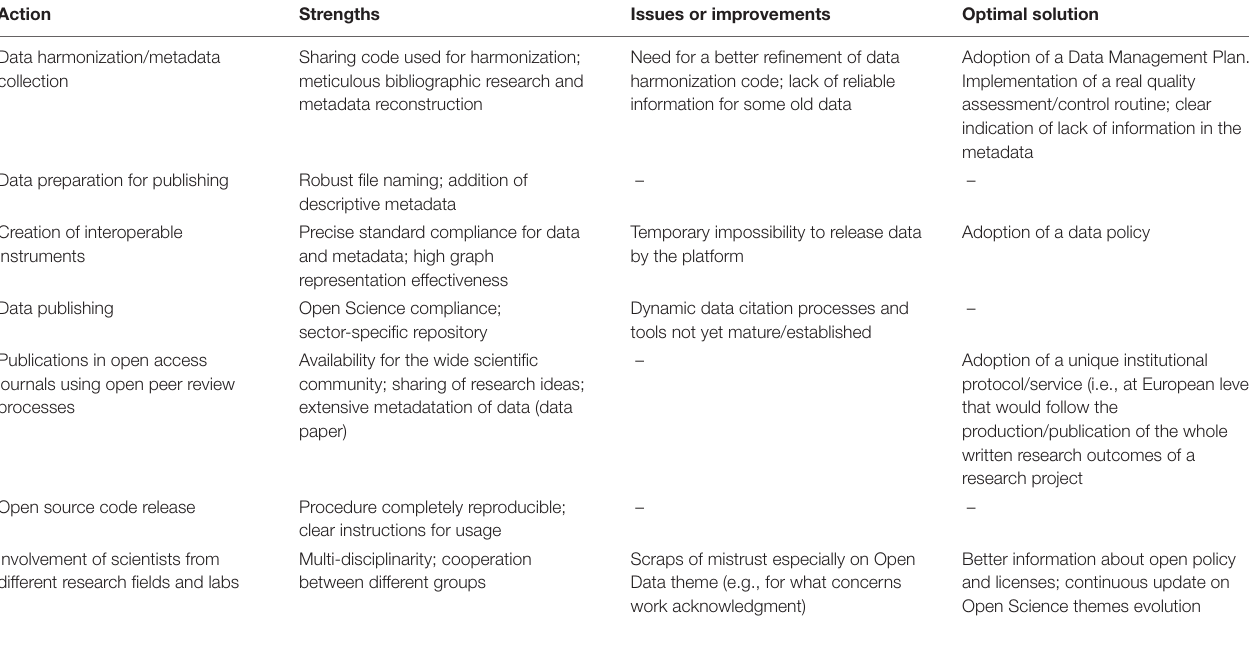
TABLE 2 | Critical overview of the different actions undertaken: strengths, issues encountered, possible improvements, and optimal solutions are shortly addressed.